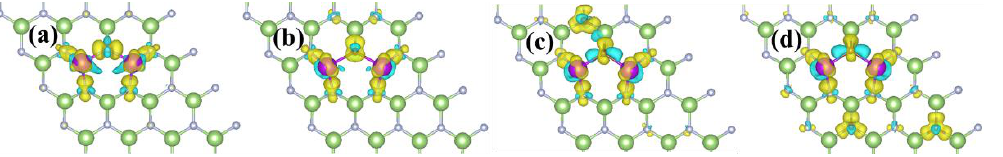
Figure 2. The charge density difference of ( a ) Ga 14 N 16 Gd 2 , ( b ) Ga 14 N 15 Gd 2 C 1 , ( c ) Ga 14 N 14 Gd 2 C 2 and ( d ) Ga 14 N 13 Gd 2 C 3 monolayers. The isosurface level is 0.009 e · Å -3 . The yellow and cyan areas indicate the positive and negative electrons, respectively.